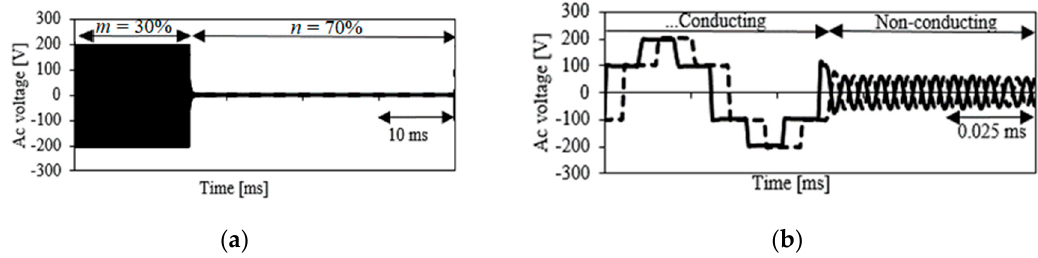
Figure 7. AC voltage waveform of the 3P-BIDC in Yy transformer connection using burst-mode. ( a ) At δ = π /6. ( b ) Time-expanded waveform of ( a ).